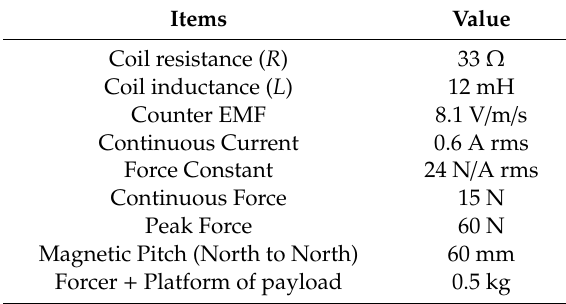
Table 1. The datasheet of proposed linear shaft motor.